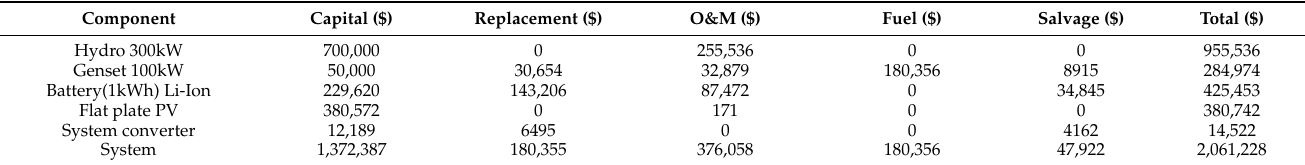
Table 6. System architectural costs for proposed hybrid system option